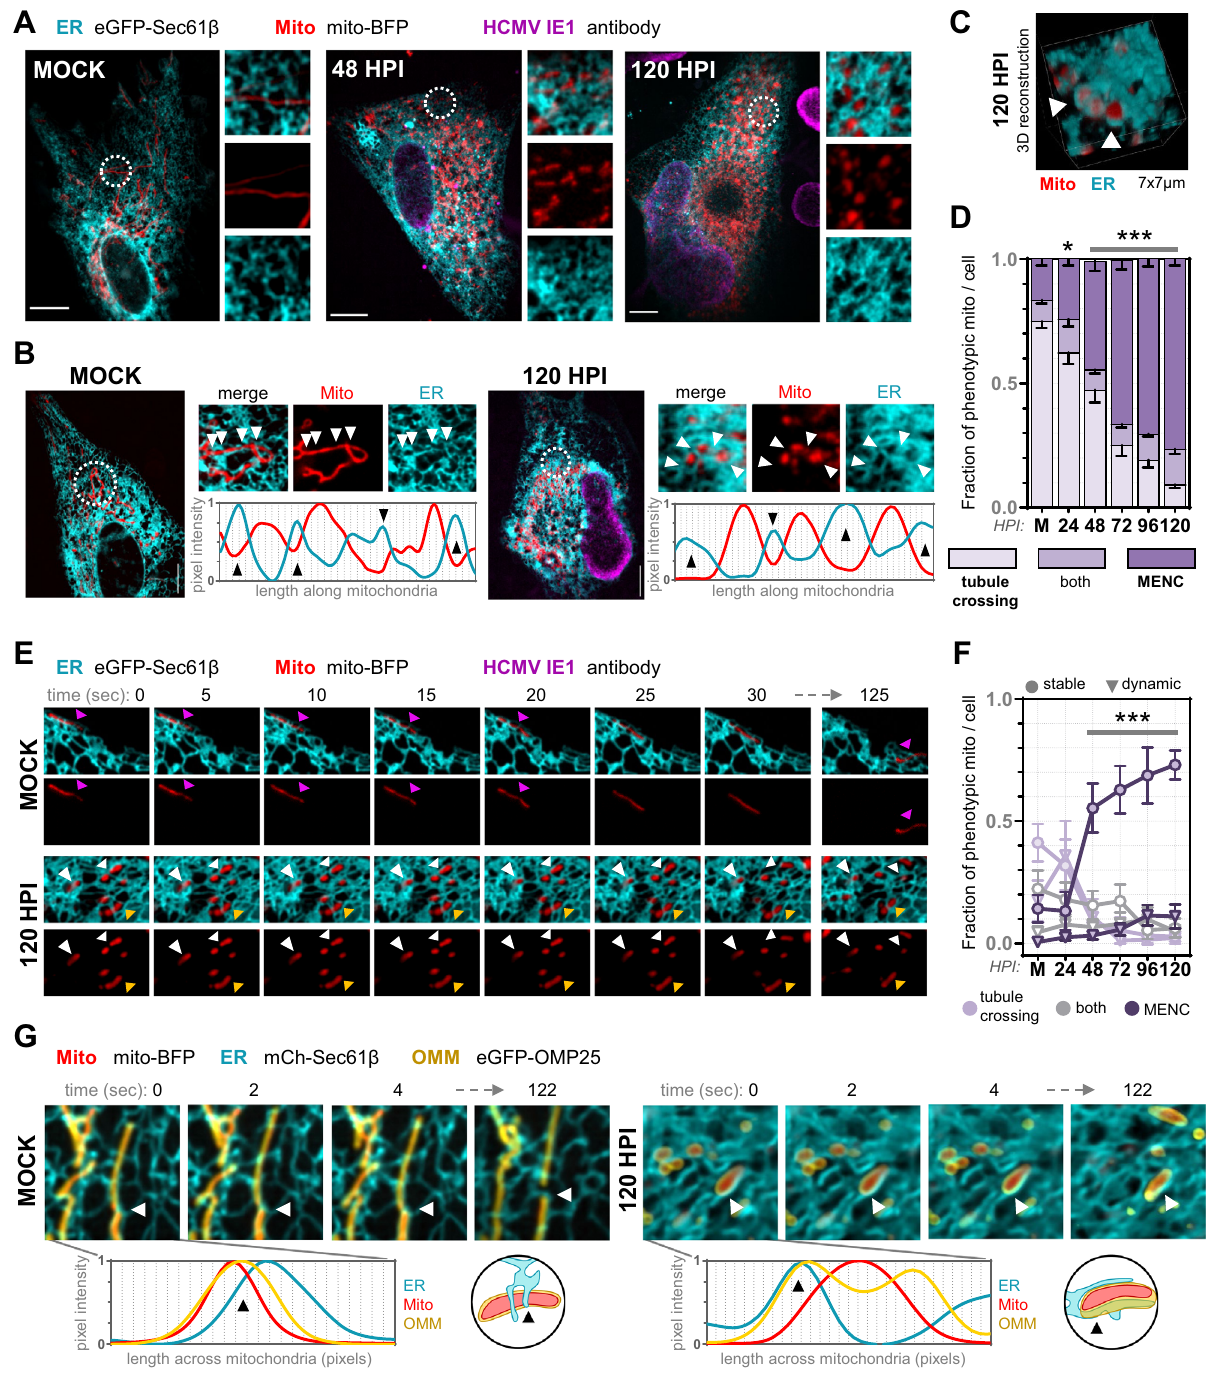
Fig. 2 | HCMV infection increases and rewires ER-mitochondria contacts into stable encapsulated structures (MENCs). A Human fi broblasts infected with HCMV and fi xed at the indicated timepoints, labeled for: ER (cyan), mitochondria (red), and the viral protein IE1 (magenta) to con fi rm infection progression. Shown arez-stackmax.projections,witha7×7 µ mregion(whitecircles)atright.Scalebars 10 µ m. See additional examples in Supplementary Fig. 7. B Line-scans of fl uores- cenceintensity along the length ofone (Mock,ERtubulecrossings) or several(120 hpi, ER encapsulations) mitochondria, with arrows marking ER crossings. C 3D reconstructionofa7×7 µ mregionfromacellat120hpiasinA,withERmembranes encasing mitochondria (MENC). D Scoring ER-mitochondria contact phenotypes every24hpifromimagesin A .Keybelow,errorbarsareSEM( ≥ 15mitochondria/cell quanti fi ed in ≥ 33 cells/timepoint, speci fi cally N =41, 35, 33, 34, 47, and 37 cells for Mock,24,48,72,96,and120hpi,respectively,correspondingtothreeindependent